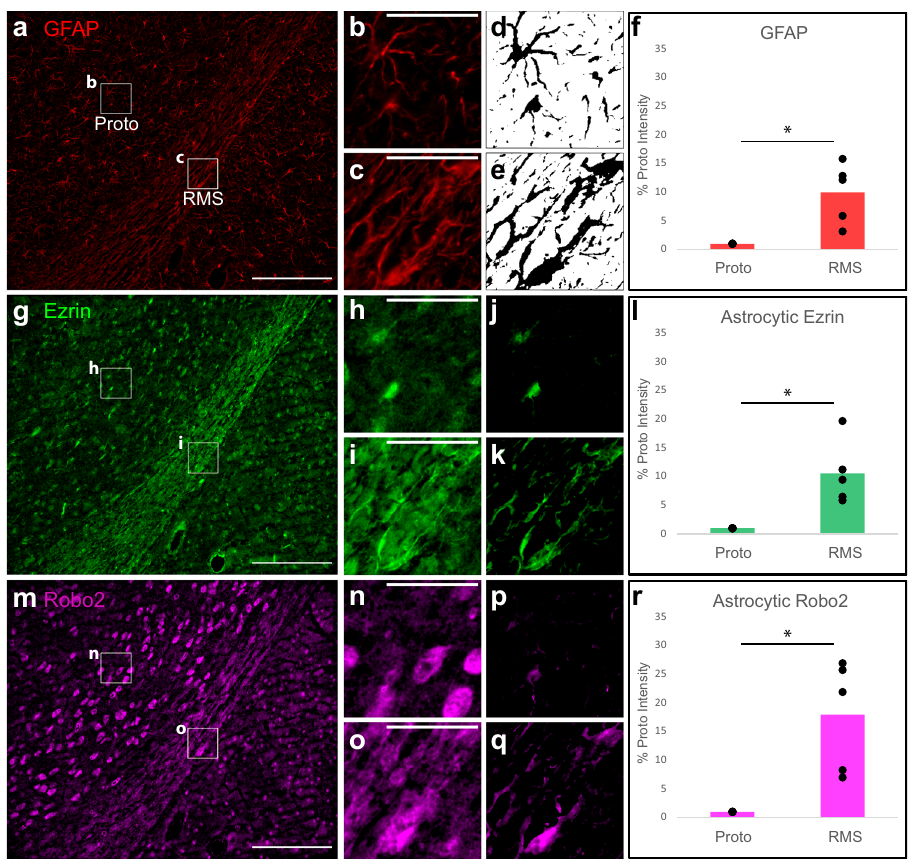
Fig. 2 Characteristic protein enrichment in RMS astrocytes relative to surrounding protoplasmic astrocytes in the rat brain. Formalin- fi xed, paraf fi n- embedded (FFPE) rat brains were sagittally sectioned and immunostained for GFAP ( a – f ), Ezrin ( g – l ), and Robo2 ( m – r ). GFAP, Ezrin, and Robo2 channels from a representative image are displayed in a wide view containing a portion of RMS and surrounding brain ( a , g , and m ), with standardized regions of interest (ROIs) annotated within for both RMS and protoplasmic (Proto) astrocytes. Enlarged ROIs are provided for each channel ( b , c , h , i , n , o ). Automated binary masks were generated from GFAP ROIs ( d , e ) to allow for the isolation of astrocytic signals from the ROIs of each channel. Images resulting from the application of these astrocytic GFAP masks to ROIs are provided for the Ezrin ( j , k ) and Robo2 ( p , q ) channels. Mean intensities were quanti fi ed from ROIs after astrocytic signal isolation, and intensity values for the Proto/RMS ROI pairs from each image were compared by paired Student ’ s t -test for GFAP ( f ), Ezrin ( l ), and Robo2 ( r ). Intensity values normalized to the Proto measurements for each pair are displayed for all fi ve animals. * p